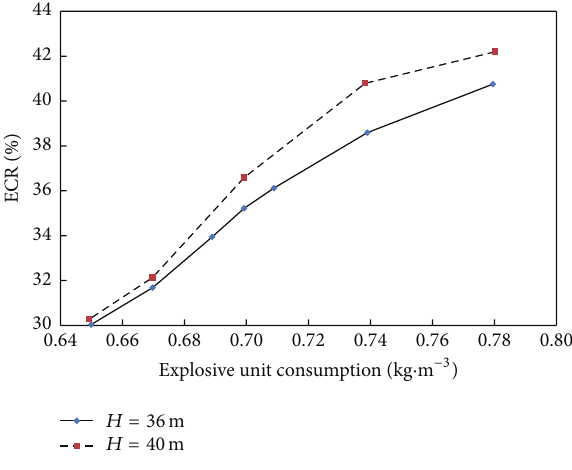
Figure 5: Relationship of casting ratio with